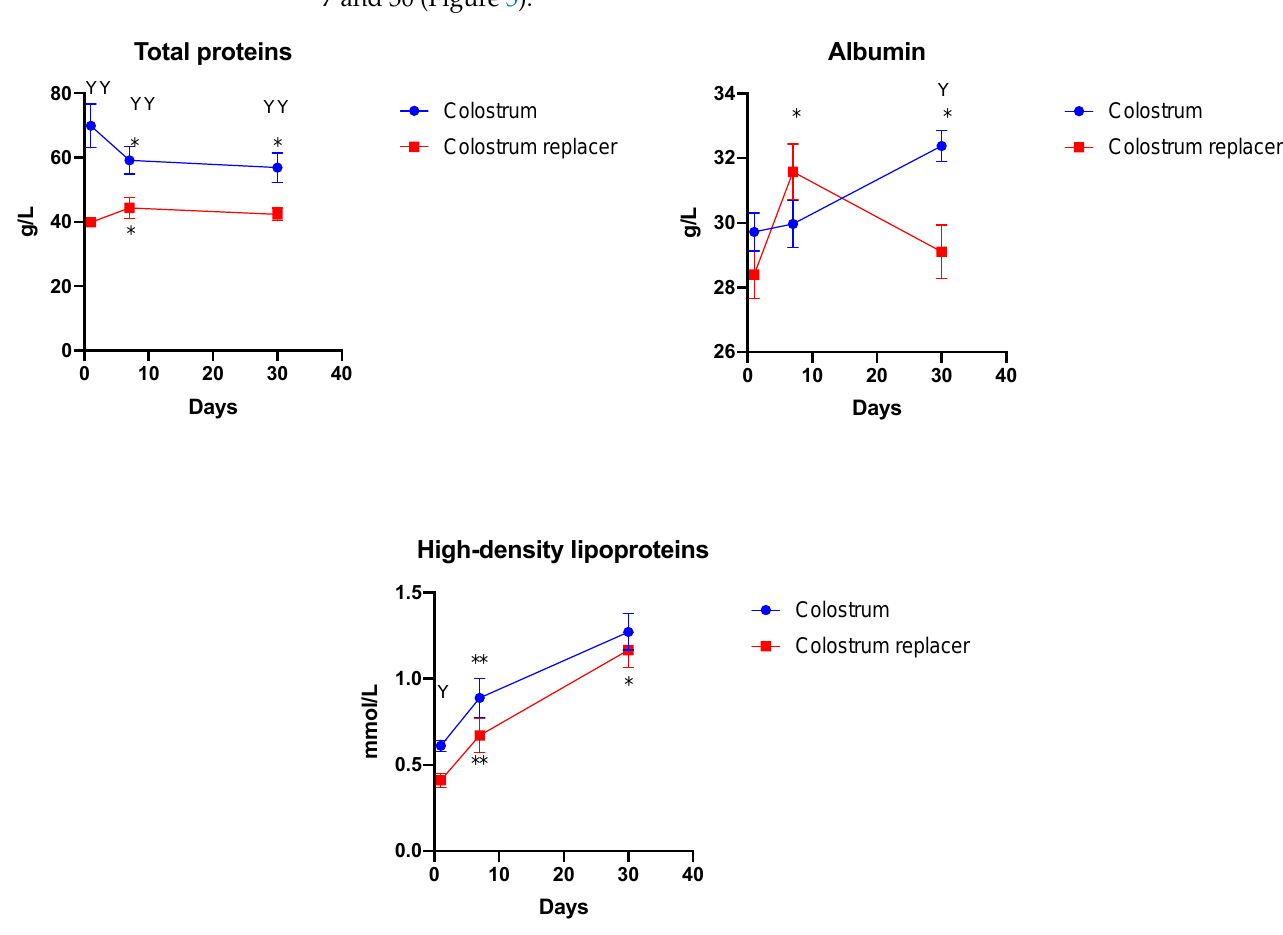
Figure 5. The changes in serum proteins and their composition in calves that received bovine colostrum or colostrum replacer. The early administration of colostrum results in a higher concentration of serum proteins in calves. The experimental animals ( n = 5 in each group) received colostrum or an artificial colostrum replacer for the first 6 h after birth. On days 1, 7 and 30, the venous blood was collected and analyzed. The high-density lipoprotein concentration was quantified by measuring the cholesterol concentration. The results are shown as mean ± SEM from five experimental animals. Ψ – p < 0.05, ΨΨ – p < 0.01 indicates significance between experimental groups. * p < 0.05, ** p < 0.01 indicates significant changes between time points of the same group.